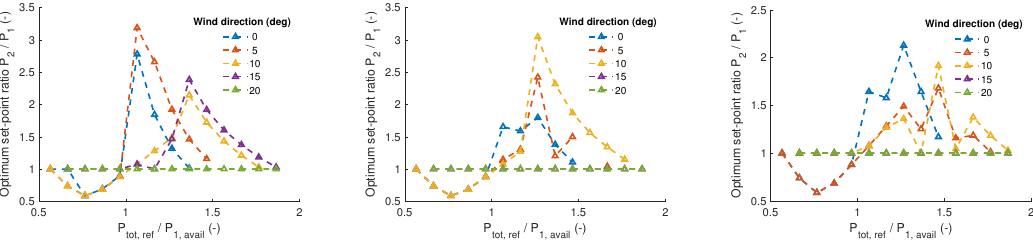
Figure 15. Optimum ratios of turbine power set-points as a function of total power reference for different wind directions and turbine spacing. The ambient wind speed is 8 m/s, turbulence intensity is 7% and turbine spacing is 5D, 7D and 9D from left to right subplots.